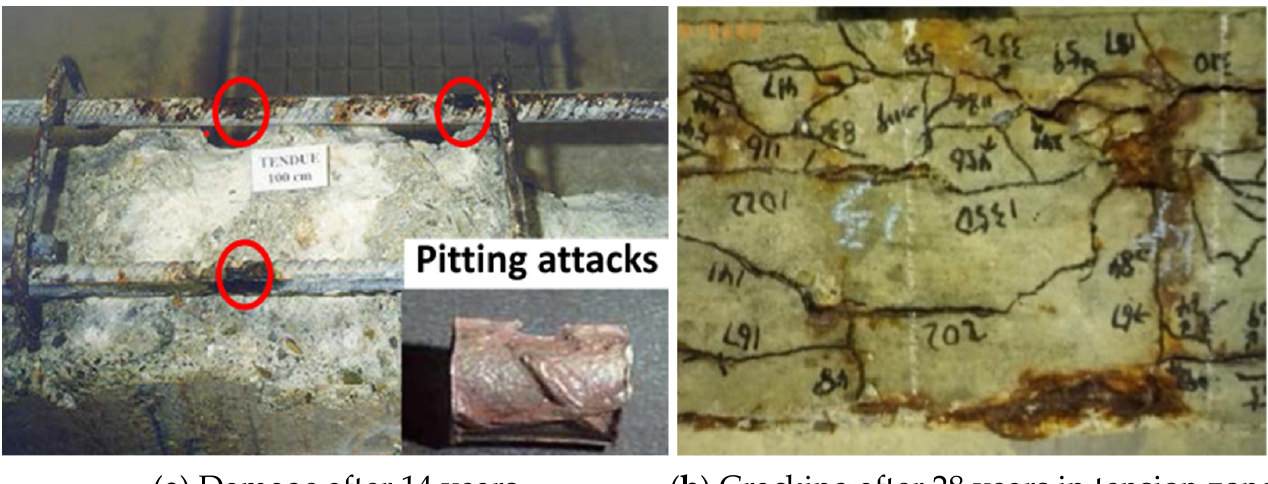
Figure 9. Intensities of corrosion damage at different ages in the beam. Reproduced with permission from [97], Elsevier, 2017.